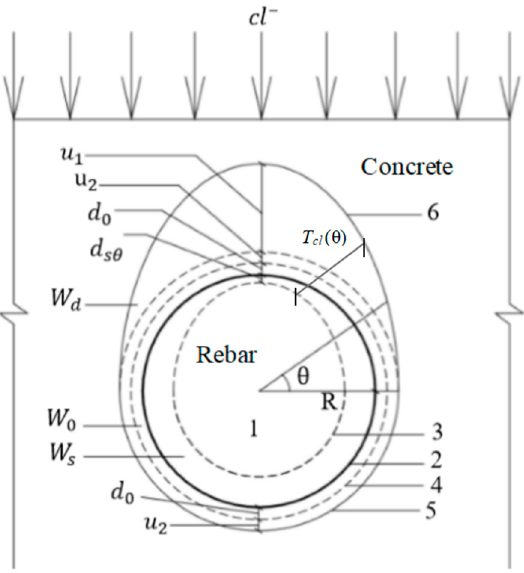
Figure 1. Deformation diagram of the corrosion products of reinforced concrete. 1: reinforcement section; 2: original reinforcement contour; 3: reinforcement corrosion contour; 4: gap contour between reinforced concrete; 5 and 6: thickness contours of the reinforcement corrosion layers on the sides farthest from and closest to the concrete protective layer, respectively.